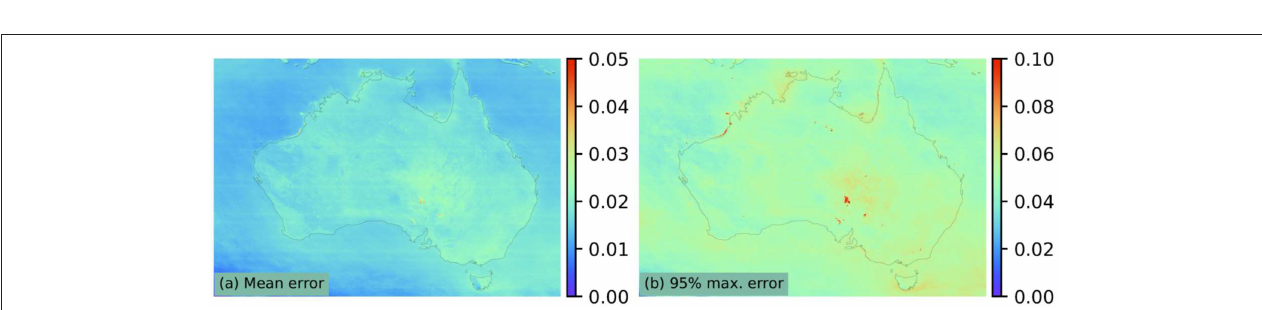
FIGURE 9 | Examples of cloud detection and cloud classification for various surface types (from top to bottom) and several cloud types. The left column shows results of time-series analysis for the detection of clouds, illustrating the sensitivity of the analysis on detection of thin or partial clouds. Detected cloudy time points are marked by red triangles along the x-axis. AHI TOA reflectance (b2 and b6) and temperature are shown along with cloud index. The right column shows cloud classification by radiative transfer modeling of AHI TOA reflectance, on 3 days when different types of clouds (shown in three colors) are present. Blue denotes cirrus clouds, green cumulus and red stratus clouds. The “Day” refers to the day since 1 September 2015. The squares are the baseline (clear day) TOA reflectance, circles are TOA reflectance, and crosses are modeled TOA reflectance.